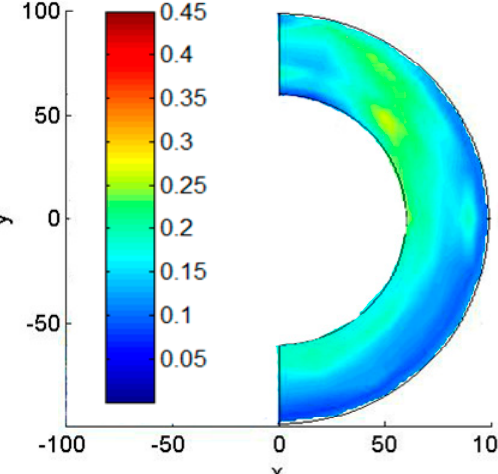
Figure 13. The distributions of bed shear stress of